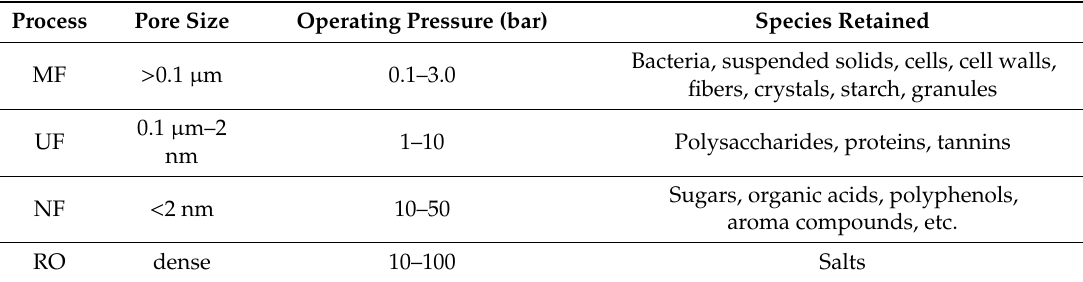
Table 1. Properties of pressure-driven membrane